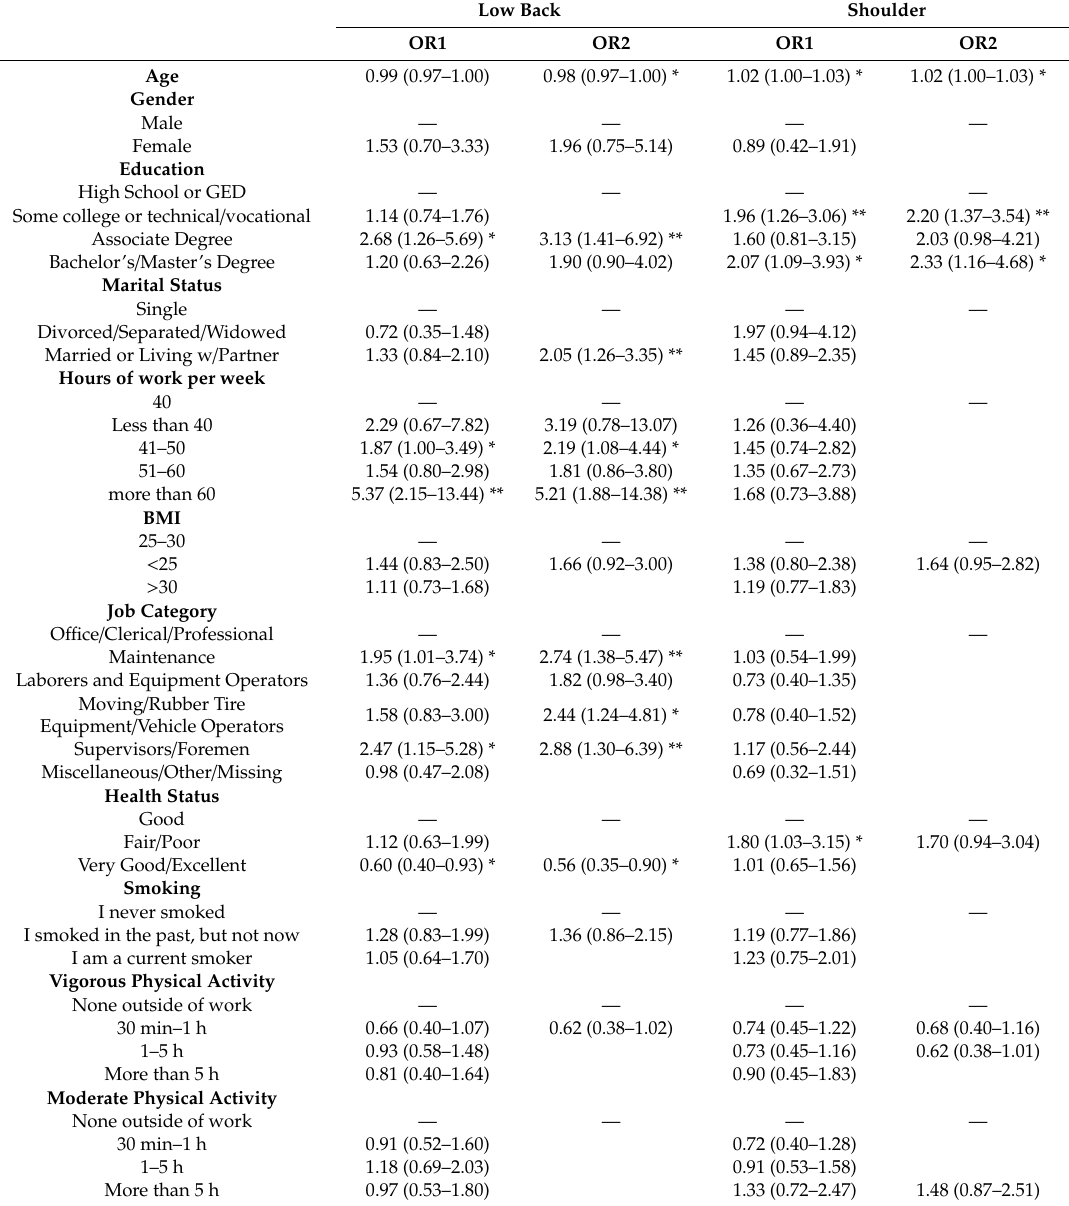
Table 2. Odds Ratios and 95% Confidence Intervals for Low Back Musculoskeletal Symptoms (MSS) and Shoulder